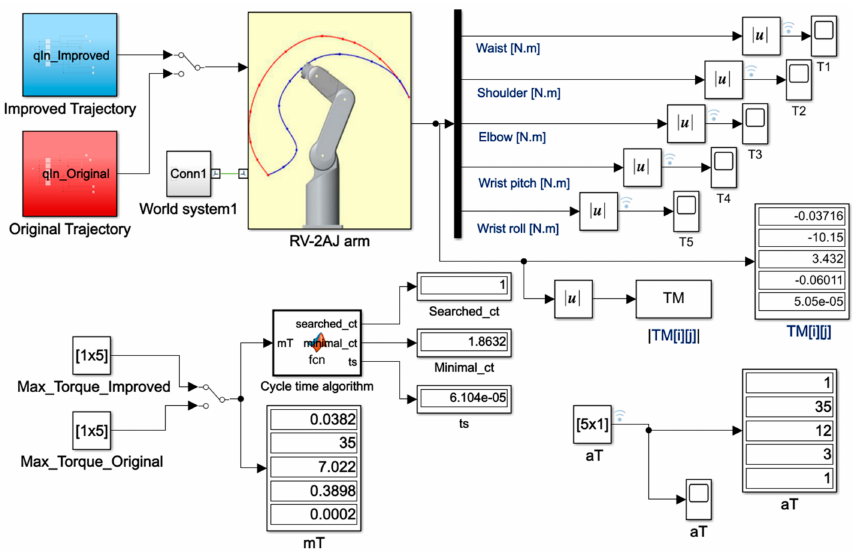
Figure 15. The block system scheme of RV-2AJ arm of the improved